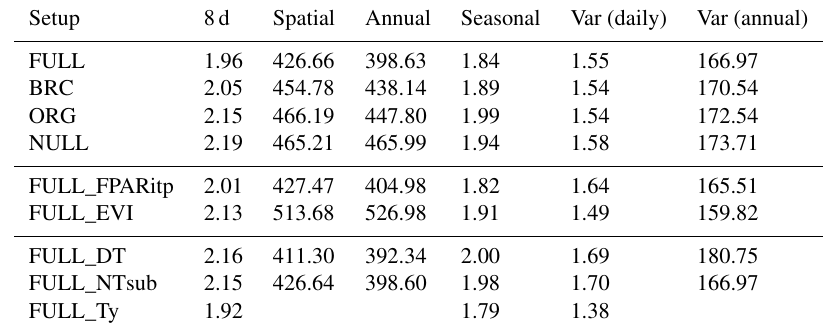
Table 4. RMSE of simulated and observed GPP based on different model setups and for different components of variability. Setup 8d Spatial